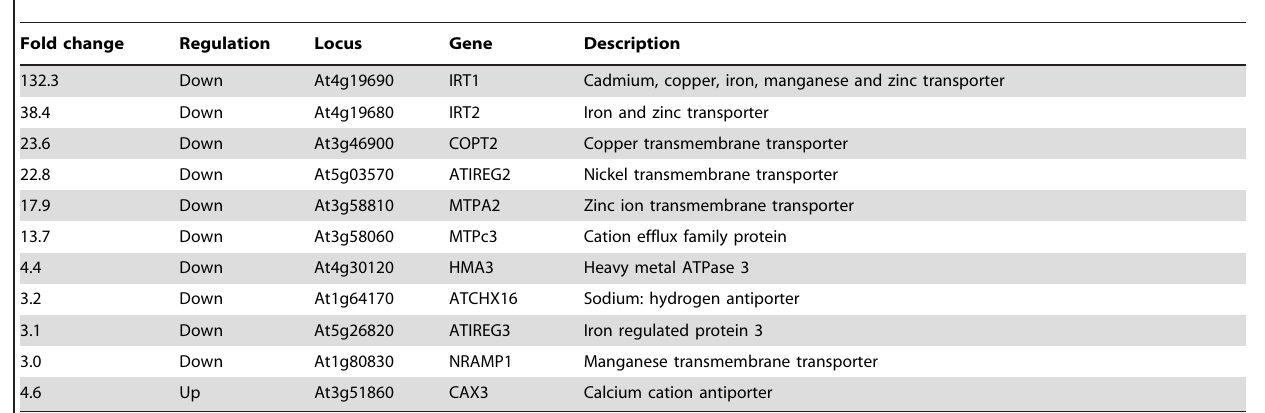
Table 5. Changes in regulation of divalent cation transporters in response to